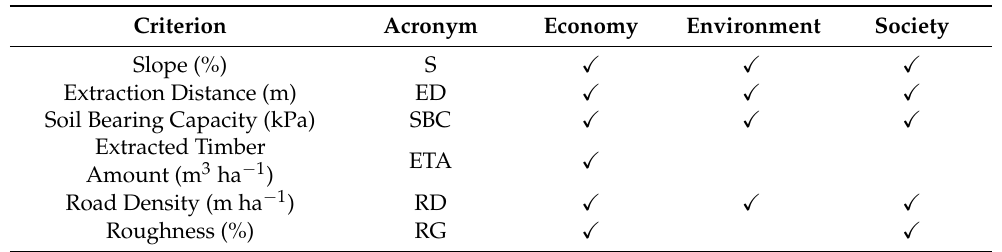
Table 1. Identified criteria for the selection of the most suitable harvesting system with reference to the various pillars of